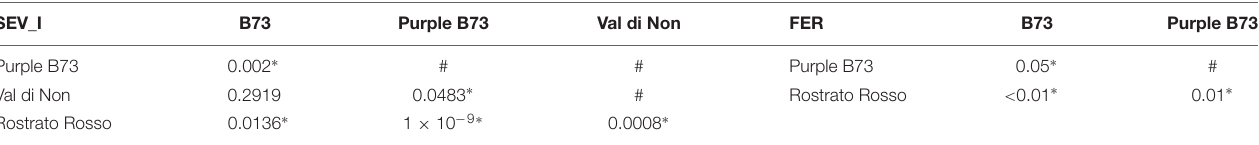
TABLE 6 | P-values after Kruskal–Dunn post hoc test on severity of infection phenotypic values following RTA inoculation with F. verticillioides (SEV_I) and in field inoculation (FER).